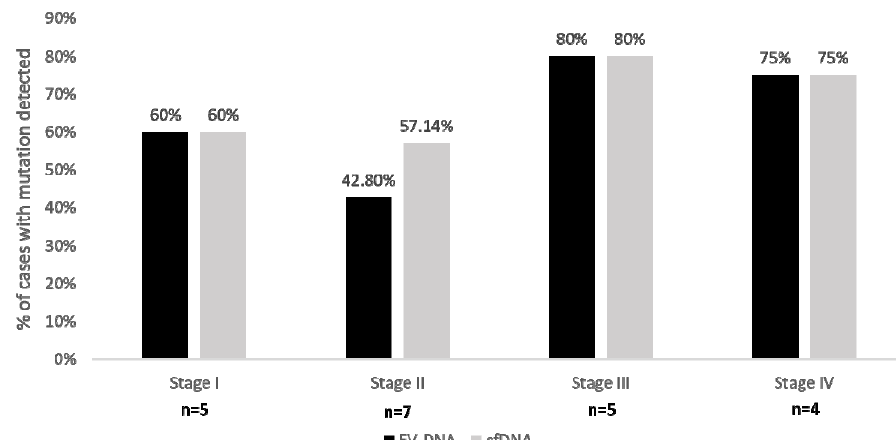
Figure 4. Comparison of mutation detection in EV-DNA and cfDNA in the four stages of colon carcinoma. Bar chart shows that the mutation detection was almost equivalent in EV-DNA and cfDNA for all the four stages of colon carcinoma ( p value = 1; Fisher’s exact test). Table 2. Mutation analysis from EV-DNA and cfDNA.